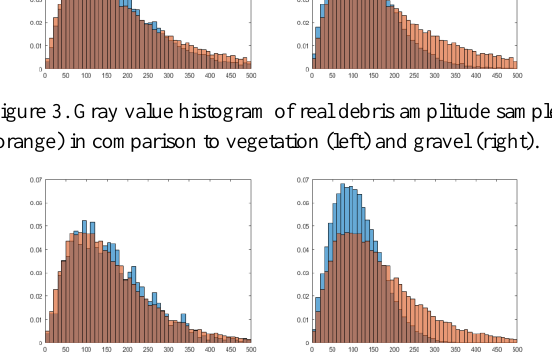
Figure 1. Exemplary 3d model for a heap of debris.